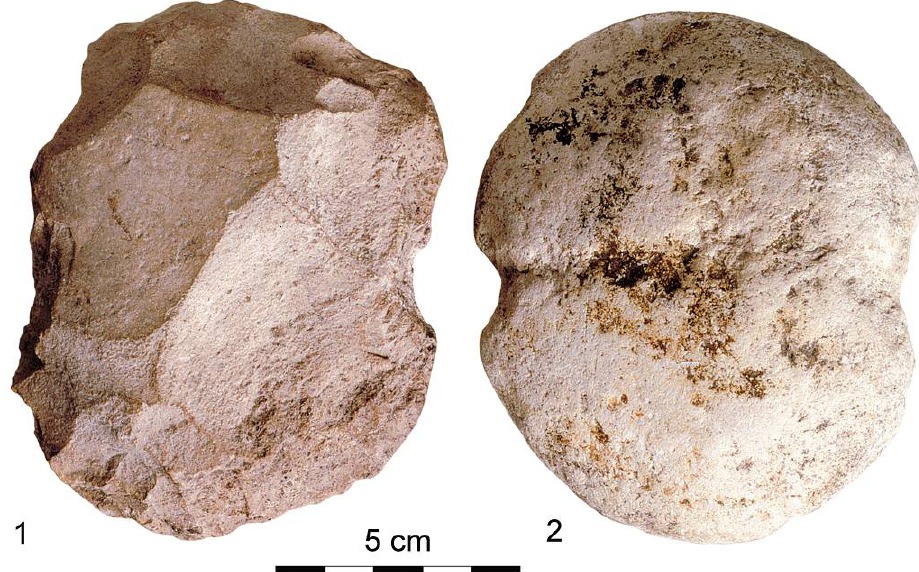
Figure 12. Stone weights made on limestone pebbles. Note the flake scars on 1 and the pecking evidence on the notches and across the implement on 2.